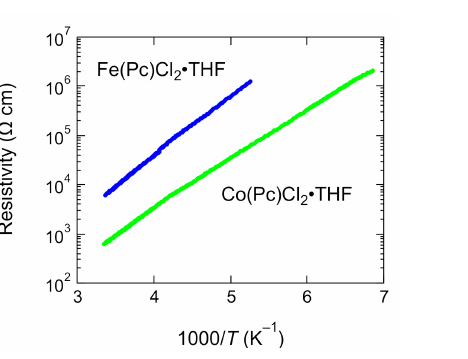
Figure 6. Temperature dependence of the electrical resistivities of Co III (Pc)Cl 2 · THF (green) and Fe III (Pc)Cl 2 · THF (blue) along the a -axis, measured by the standard four-probe